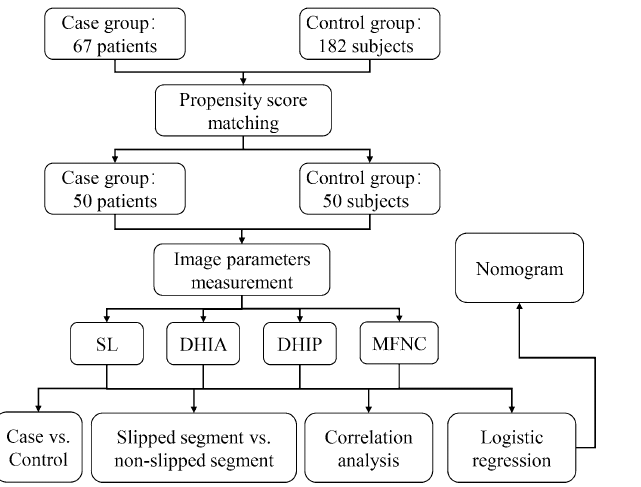
Figure 6. The workflow of our